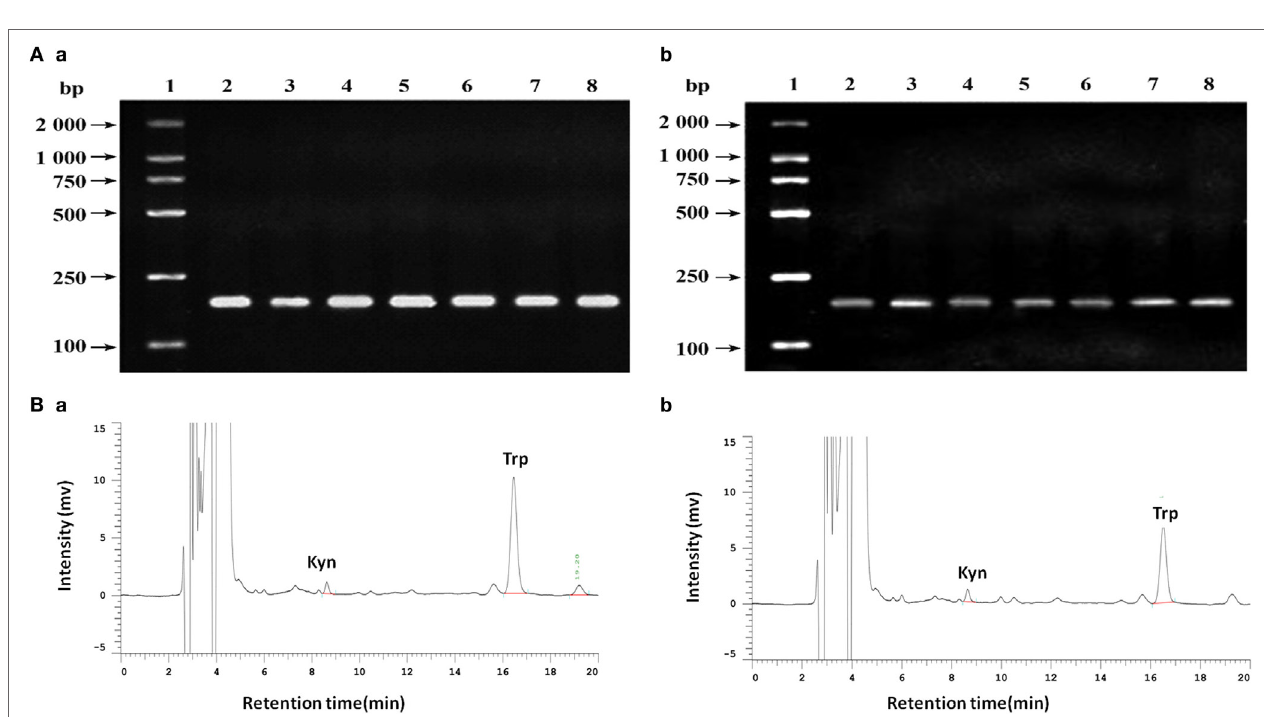
FigUre 4 | The survival curves for breast cancer patients after 68 months (range: 20–97 months) follow-up times, the patients with indoleamine 2,3-dioxygenase (IDO) expression or high microvessel density (MVD) level had poorer prognosis compared with no IDO expression [ P = 0.108 for OS and P = 0.047 for progress-free survival (PFS)] and low MVD level ( P = 0.019 for OS and P = 0.052 for PFS); the patients with IDO expression and high MVD level had a tendency with shorter overall survival ( P = 0.062 for OS and P = 0.112 for PFS).